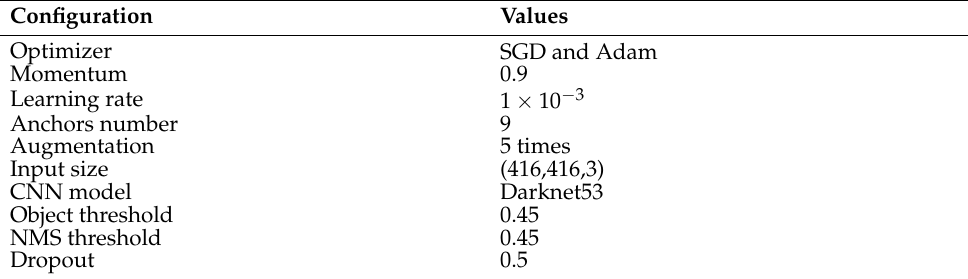
Table 9. The YOLOv3 hyperparameter